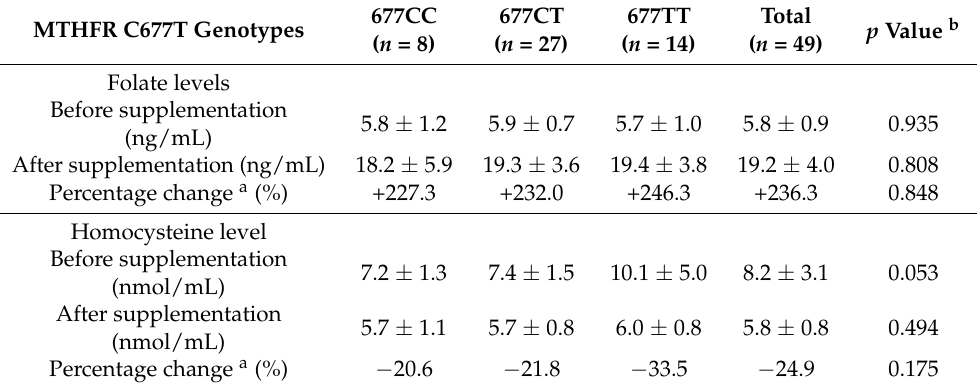
Table 2. Impact of multivitamin supplementation on folate and homocysteine